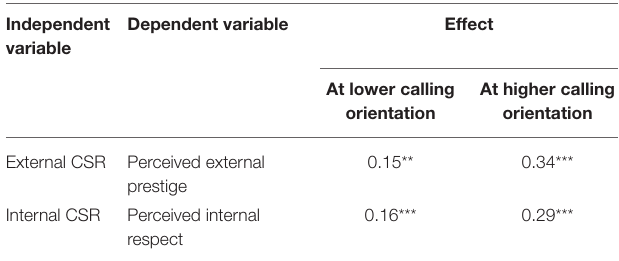
TABLE 5 | Simple slope